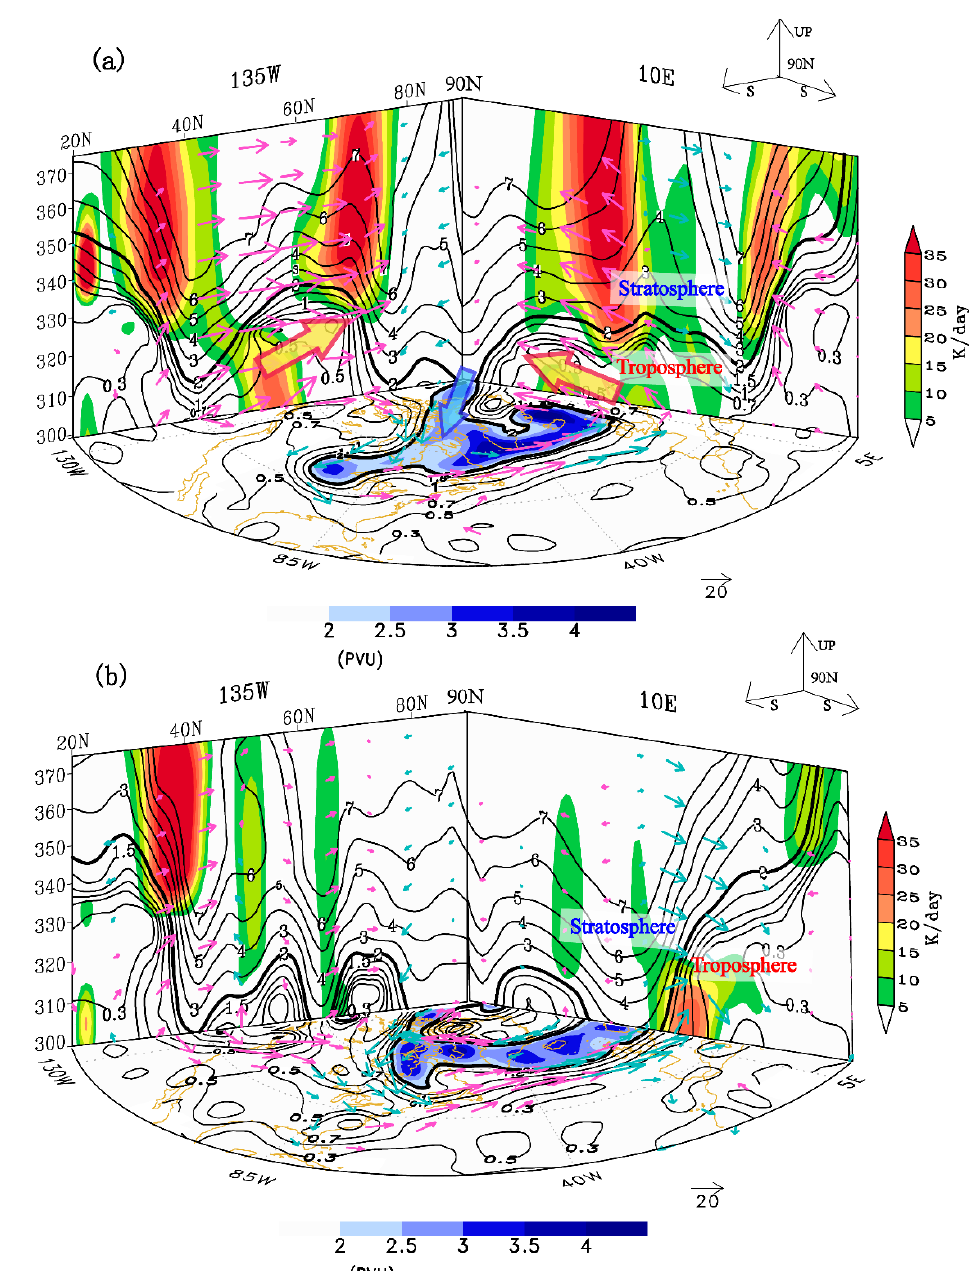
Figure 9. The three-dimensional map of PV (contours, thickened black contours of 2 PVU represent the dynamic tropopause), diabatic heating (red-yellow-green shading in the top two panels) and wind field (the purple and blue arrows indicate southerly and northerly, respectively) between North America and Western Europe on ( a ) 15 and ( b ) 18 January 2018: (bottom) 300 K isentropic surface (area with >2 PVU PV is filled with blue shading); (top) latitudinal-isentropic height profiles along 135° W and 10° E.